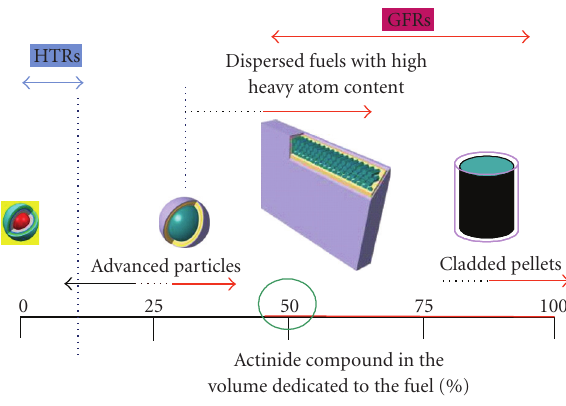
Figure 4: Candidate fuel concepts for